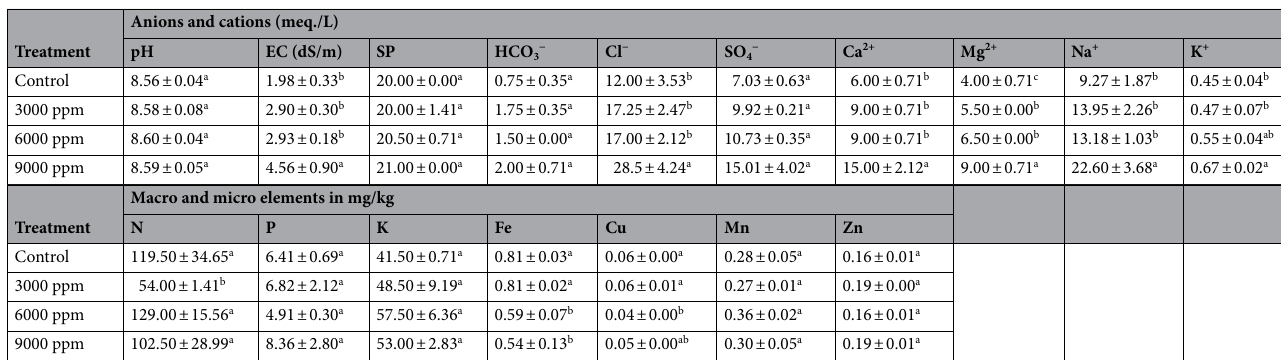
Table 6. The physical and chemical properties of the experimented sand at final harvesting . Data expressed as mean ± SD (n = 3). EC electroconductivity, SP particle size distribution, HCO 3 − hydrogen carbonate ions, Cl − chloride ions, SO 4 − sulfate ions, Ca 2+ : calcium ions, Mg 2+ magnesium ions, Na + sodium ions, K + potassium ions, N nitrogen, P phosphorus, K potassium, Fe iron, Cu copper, Mn manganese, Zn zinc. Different lower superscript letters within the same column indicate a significant difference within the treatments at p <